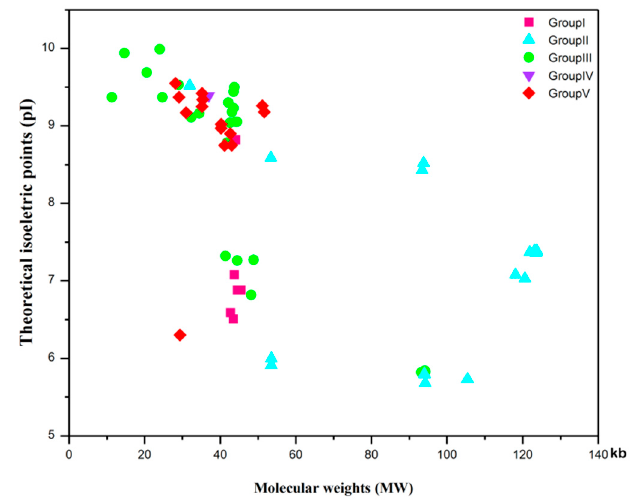
Figure 12. The PI and MW of TaSBP proteins were predicted by ExPASy10. The five different subfamilies were indicated by different